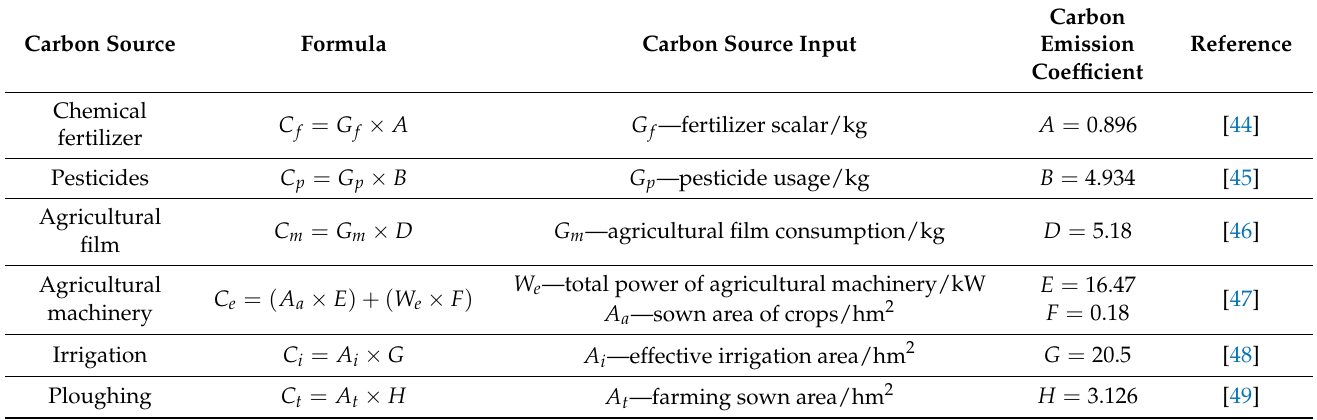
Table 1. Calculation formula and carbon emission coefficient of each carbon emission